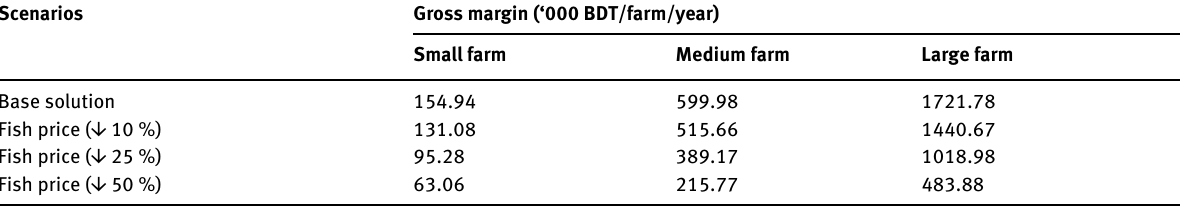
Table 6: Fish price decreasing effect on gross margin